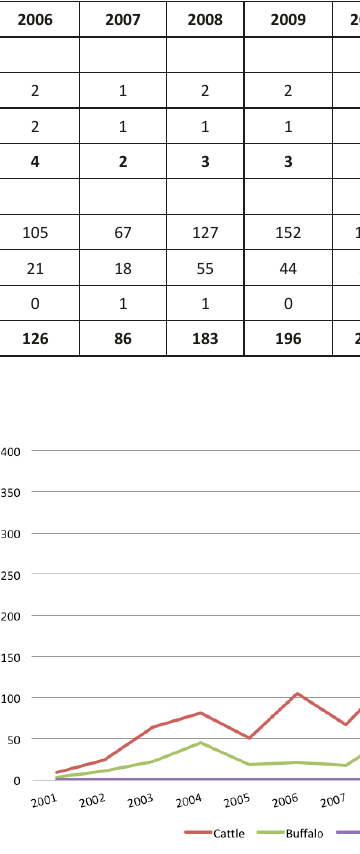
Figure 4. Showing rising trend of livestock depredation from